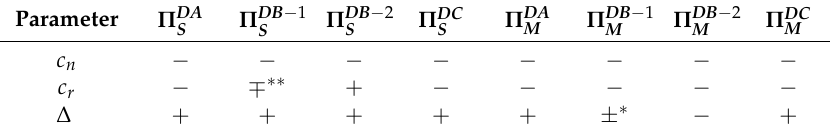
Table 7. Sensitivity analysis of the supplier’s and the manufacturer’s optimal